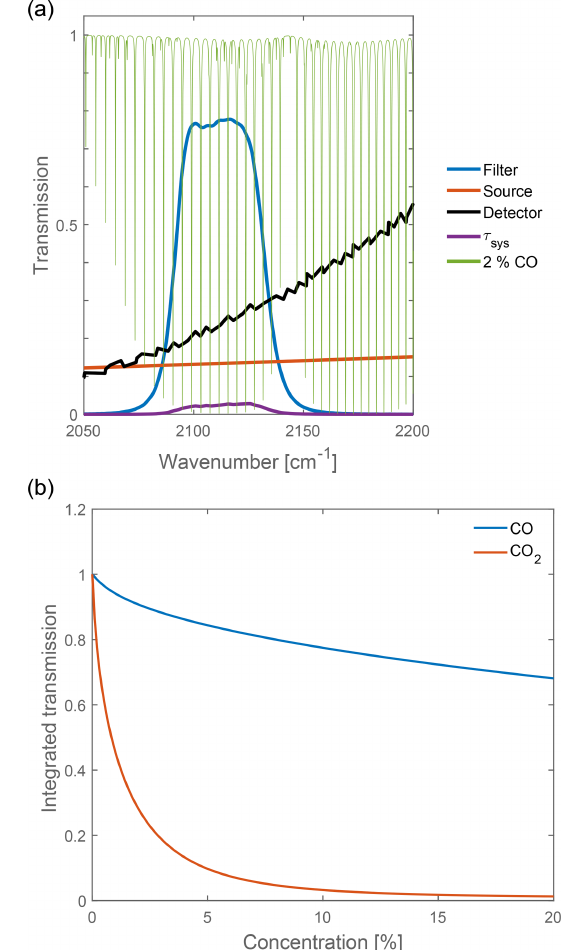
Figure 2. (a) Spectral influences on the measured signal. The area beneath τ sys is the integrated transmission which is equivalent to the measurement signal. (b) Calculated integrated transmission for CO and CO 2 for an absorption length of 5cm. The difference in the curves shows the need for two different absorption path lengths in the setup to acquire a desirable resolution.